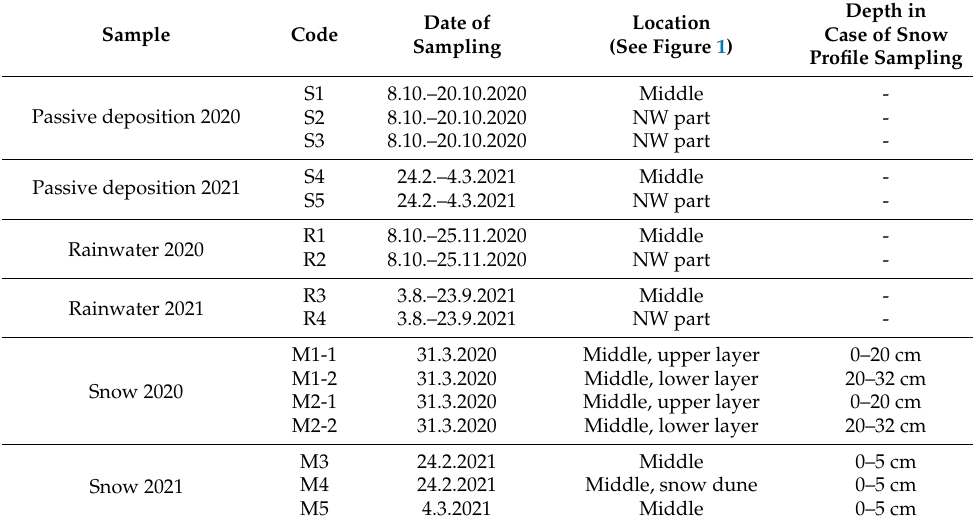
Table 1. List of collected samples, dates of sampling, and sampling locations.